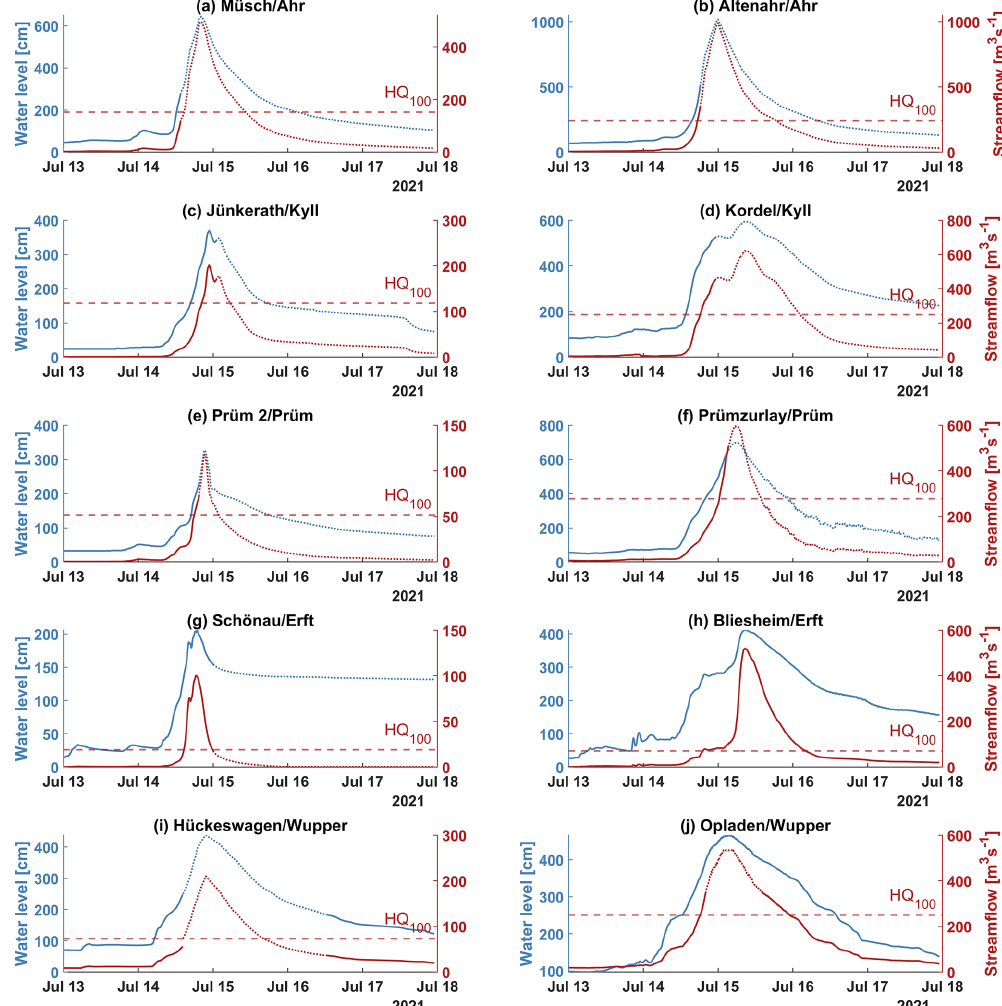
Figure 6. Time series of water level (blue) and streamflow (red) for river gauges in the Ahr, Kyll, Prüm, Erft, and Wupper river basins (13 July 00:00UTC to 17 July 2021 23:00UTC; resolution: 15min). Solid lines indicate values based on in situ measurements, dashed lines indicate reconstructed values (carried out by the data-providing water authorities). Dashed horizontal lines indicate the magnitude of the statistical 100-year flood in m 3 s − 1 . Further details about the gauges are given in Table